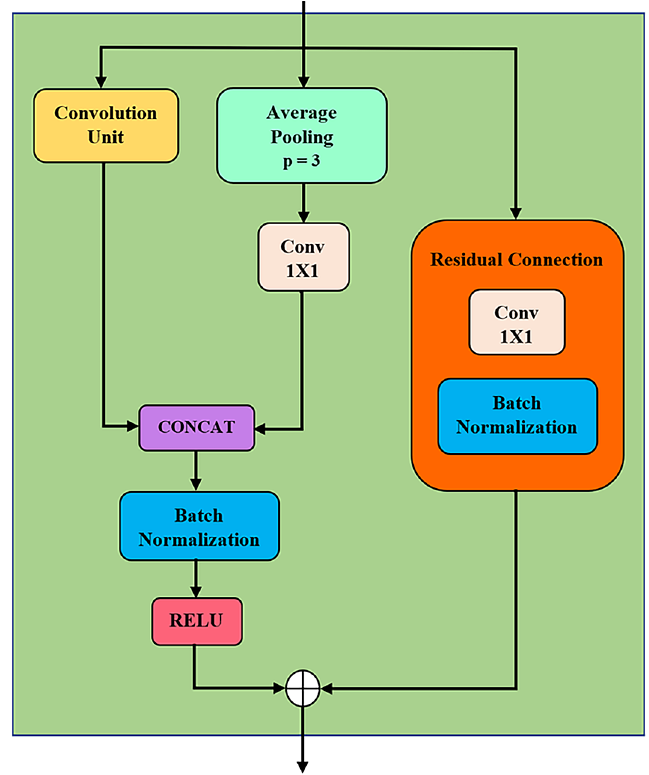
Figure 2. MSD block. (concat = concatenation, conv = convolution and p = pooling factor).